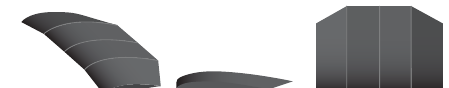
Figure 2: New compound wing configuration designed in UTM